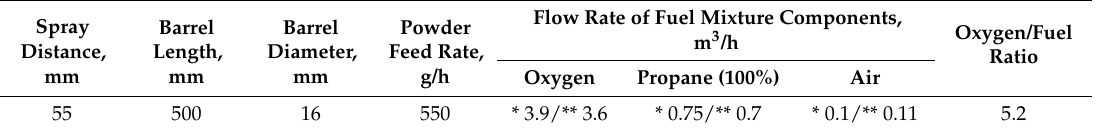
Table 1. Spraying parameters of zircon